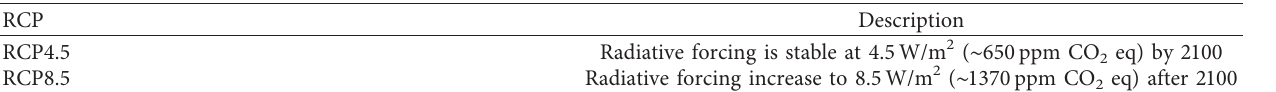
Table 3: Overview of RCP4.5 and